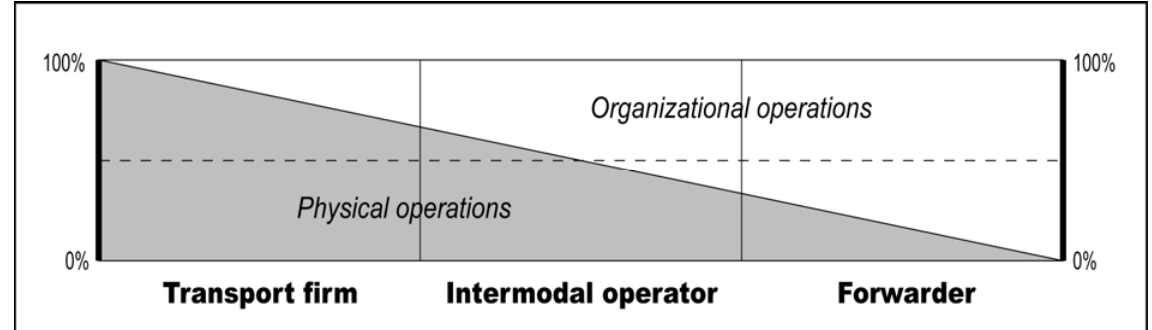
Figure 2. Main economic rationale of the three types of firms Source: drawn by